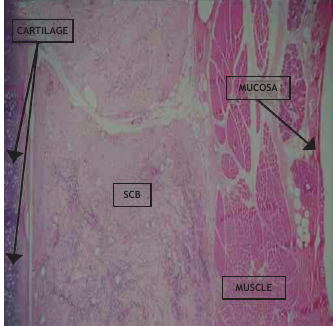
Figure 1 Photomicroscopy of rabbit right vocal fold 3 weeks after SCB implantation. Note the biopolymer deposits among the skeletal muscle fibers, with no mucosal alterations. (HE staining,